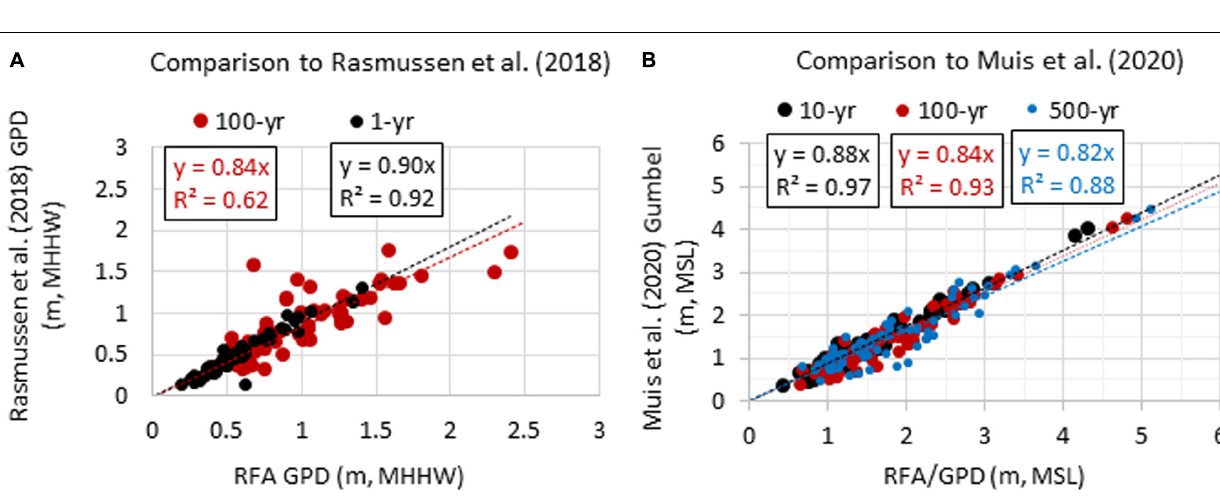
1.5 ◦ C (Hoegh-Guldberg et al., 2018) and SROCC (Oppenheimer et al., 2019) assessments. The comparison with Rasmussen et al. (2018) results is made at 61 of the 84 TGs in our study. The RFA 1- and 100-year LESLs are both higher overall, by about 10 and 16%, respectively based upon linear regression ( Figure 8A ). For context, the median ( ± 1 SD) TG difference of the 1- and 100-year LESLs being compared in Figure 8A